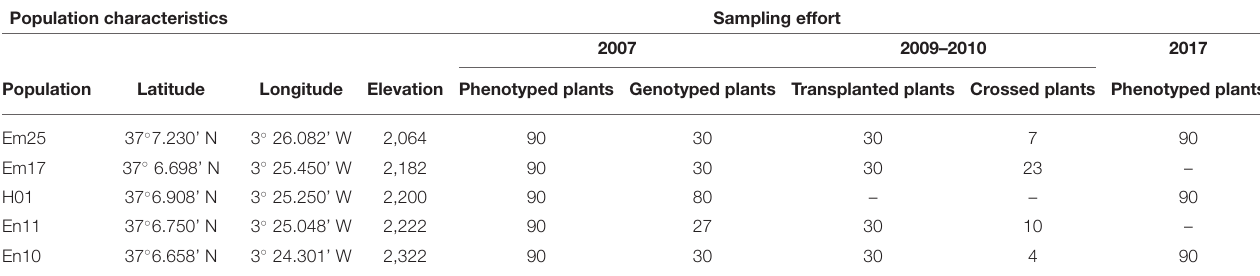
TABLE 1 | Geographic information and sampling effort in the five populations included in the study (ordered by elevation). Population